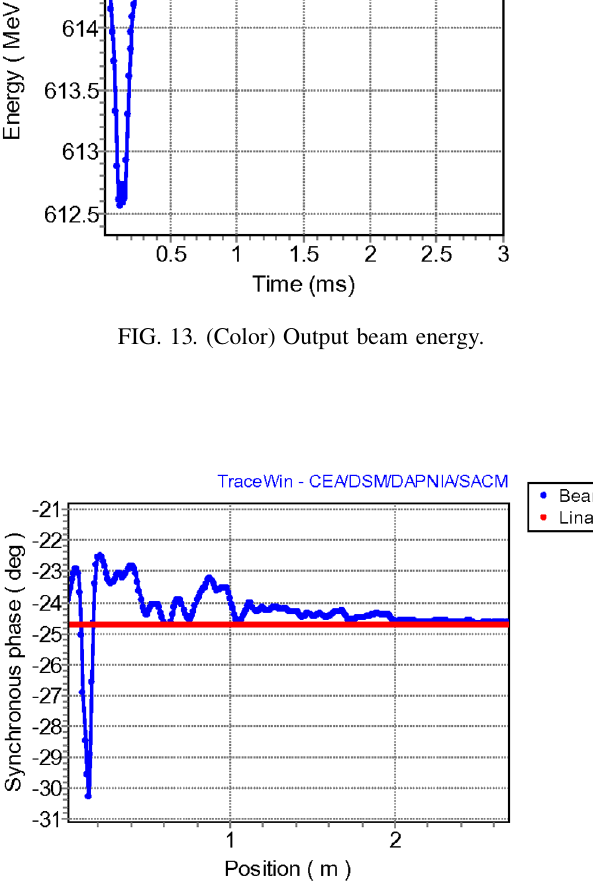
FIG. 14. (Color) Beam synchronous phase at last cavity. FIG. 15. (Color) Emittance evolution during the first